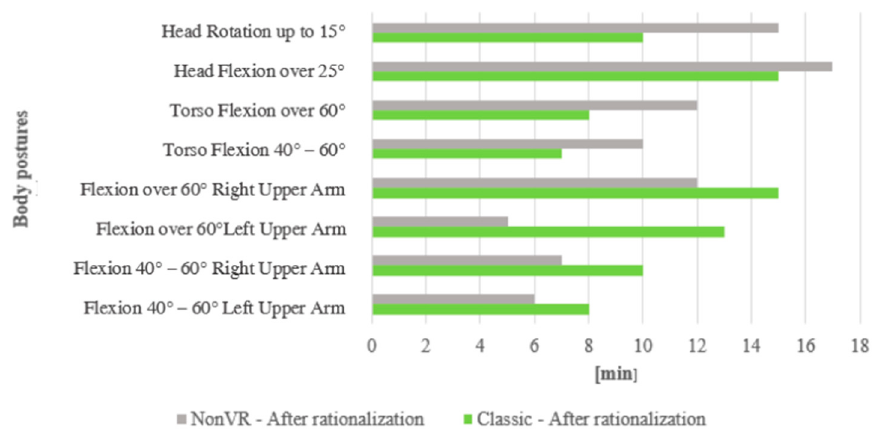
Figure 10. Measurements for NonVR and Classic methods .